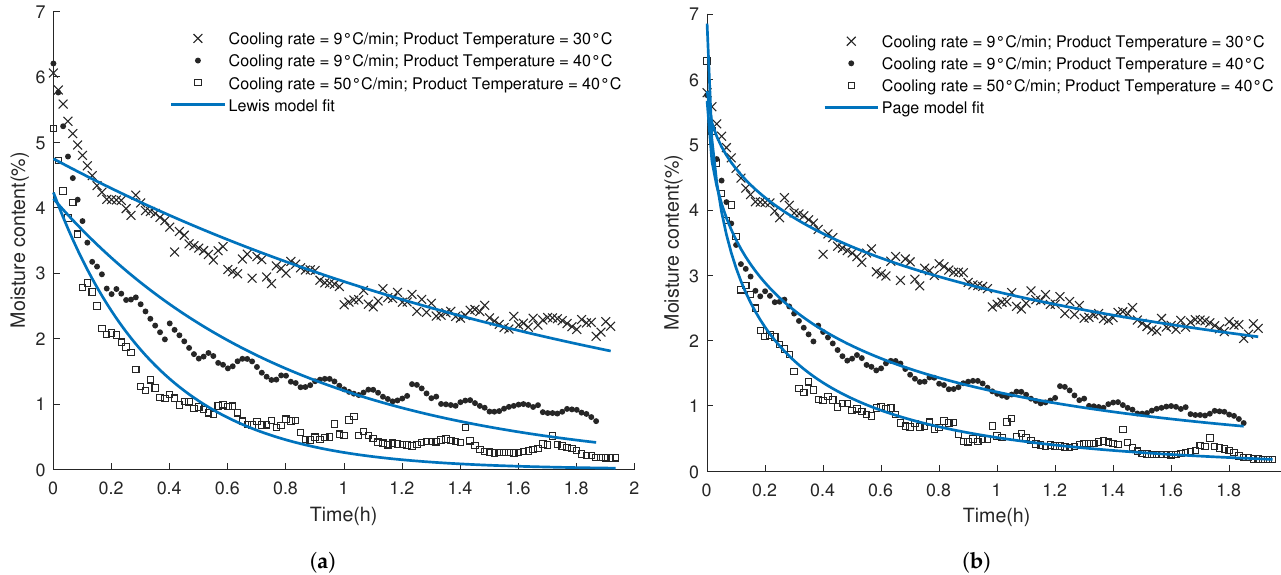
Figure 4. NIR-based inline moisture content prediction in function of time for run 5, 7, and 8; Fitting of the data was done using either the Lewis ( a ) or Page ( b ) drying